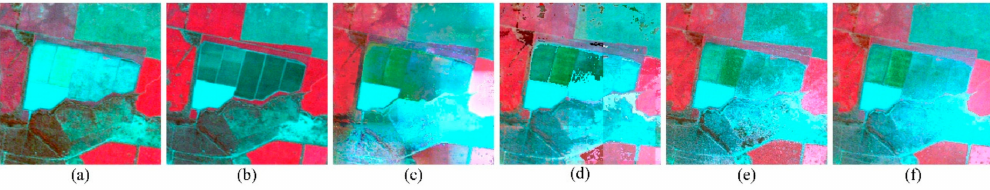
Figure 5. Zoomed in scenes of the black square areas marked in Figure 4. From left to right, ( a ) true Landsat image of 5 July 2004(base date); ( b ) true Landsat image of 6 August 2004(prediction date); ( c – f ) predicted images of 6 August 2004 by STARFM, STRUM, FSDAF and EFSDAF, respectively.